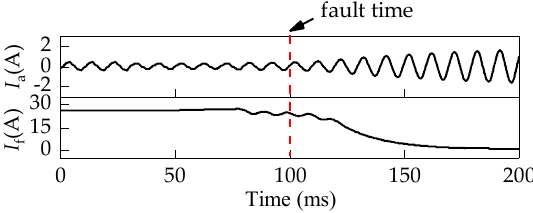
Figure 4. Recorded waveforms of the SC’s quantities during LOE Figure 4 . Recorded waveforms of the SC’s quantities during LOE fault.